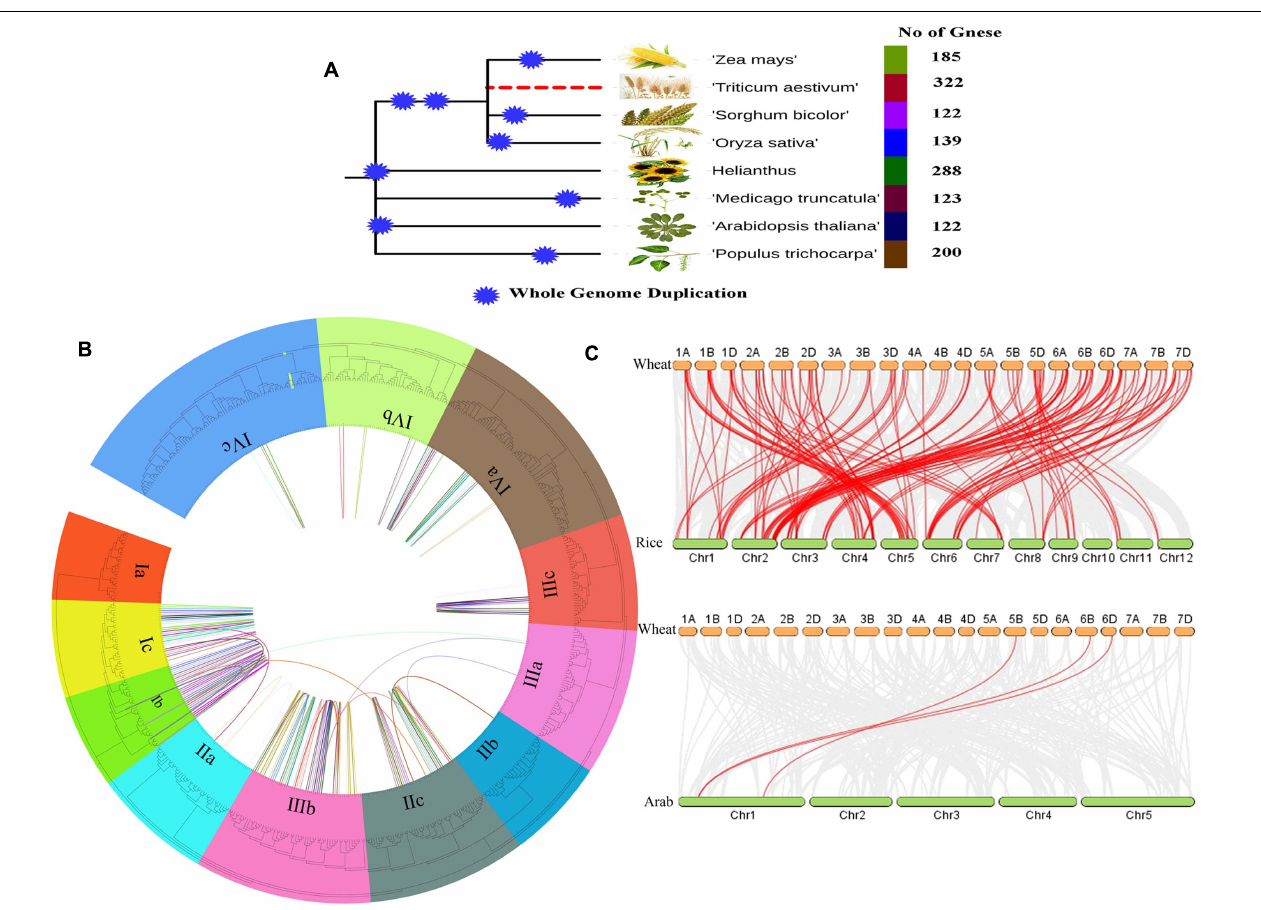
FIGURE 2 | (A) Total number of AP2/ERF genes in different crops during Whole Genome Duplication analysis, (B) The Phylogenetic tree and Microsynteny analyses of AP2/ERF genes family among wheat, rice, and Arabidopsis . (C) Collinearity relationship of AP2/ERF genes in wheat, rice, and Arabidopsis .